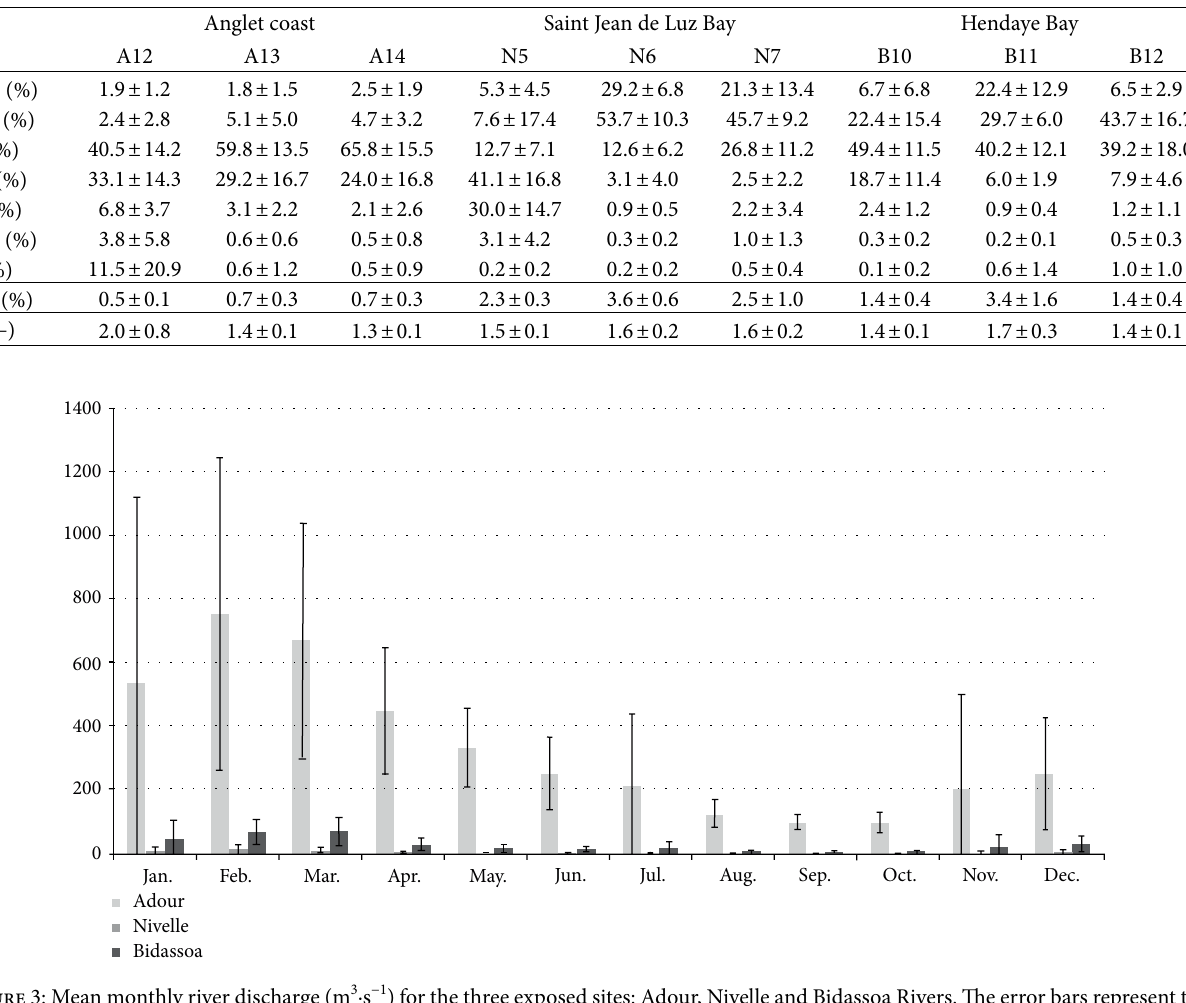
The dendrogram produced by the hierarchical agglom- erative clustering distinguished three main groups of sta- tions corresponding to three main different species assemblages (Figure 4): the first dichotomy of the dendro- gram, separated species assemblage A from the other two assemblages (B and C), which displayed a higher level of similarity (Figure 4).